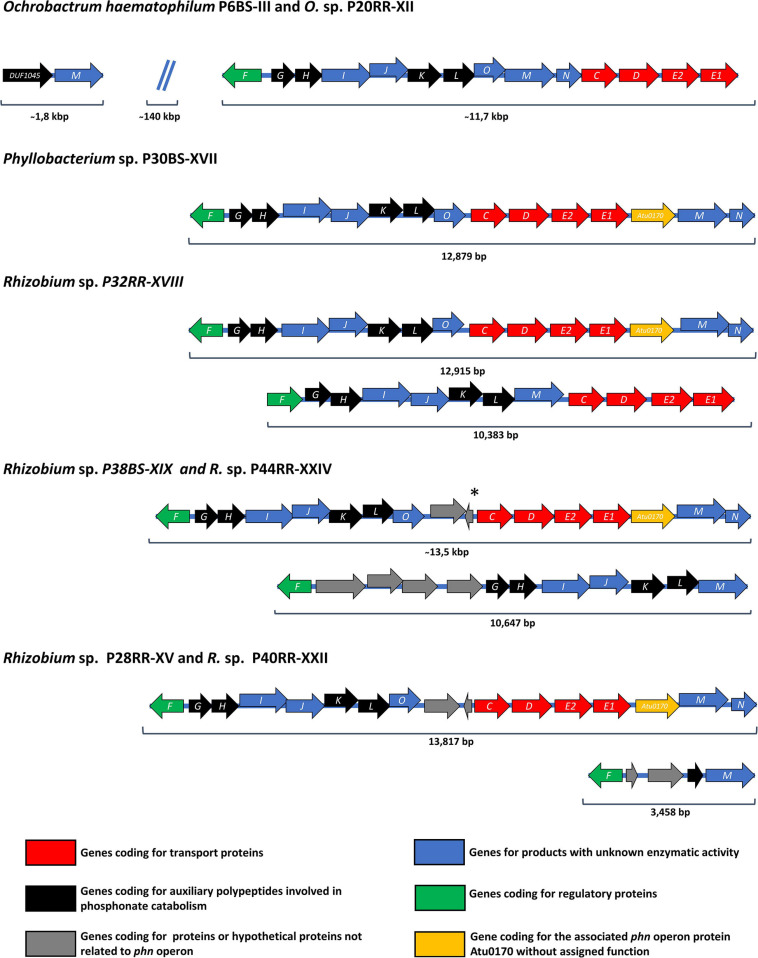
Organization of C-P lyase pathway-encoding phn operons in the investigated microbial strains. Open reading frames are shown as arrows indicating the direction of transcription and including the specific letter designation of the phn operon inside. A Displacement of an open reading frame relative to the previous open reading frame indicates an overlapping of the reading frames. At the bottom of the figure, colored squares indicate the function of each open reading frame presented above in the figure. The color nomenclature corresponds to that presented in Hove-Jensen et al. (2014). The phn operon organization of O. haematophilum P6BS-III was included in the analysis for comparative reasons. *Hypothetical open reading frame not present in Rhizobium sp. P38BS-XIX.